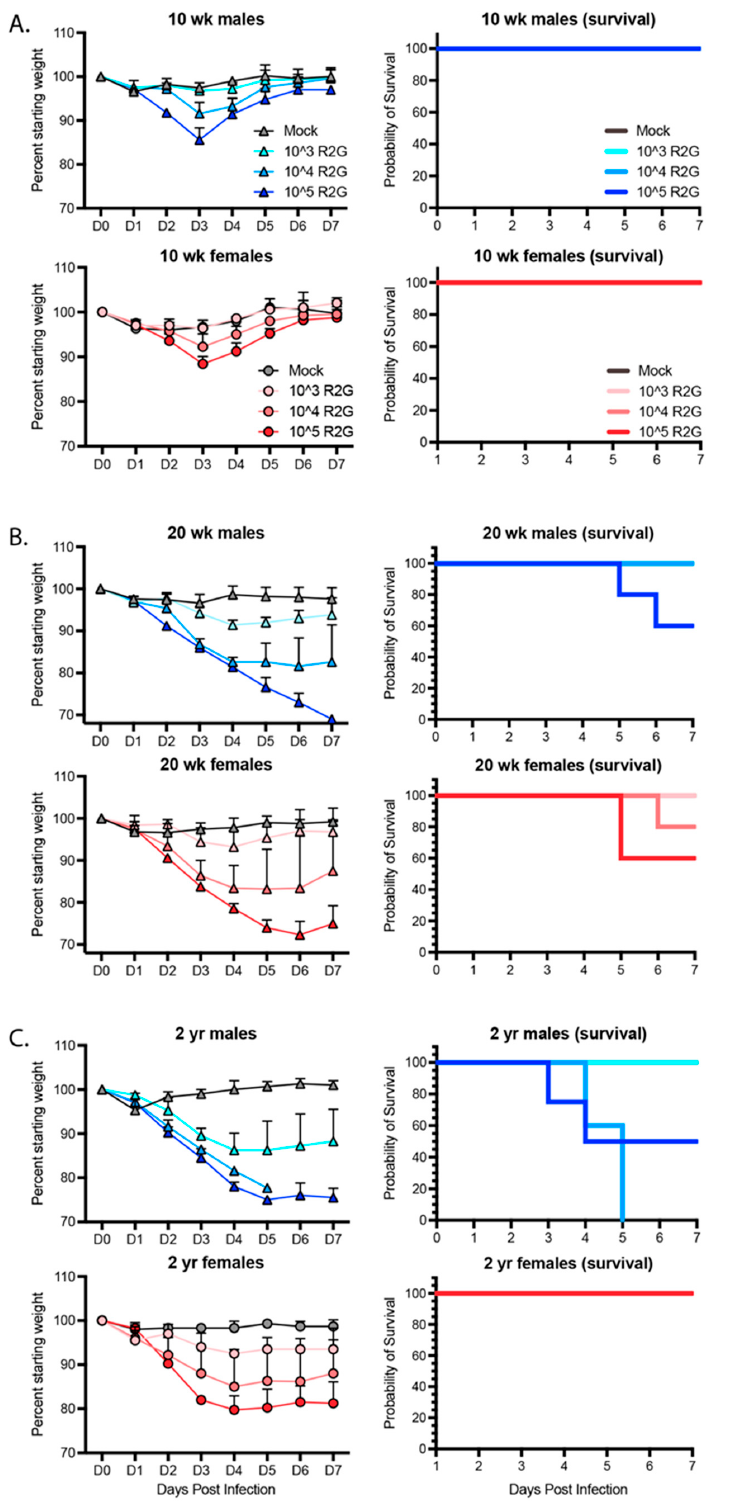
Figure 3. Dose, age, and sex dependent response to R2G in terms of weight loss and survival for 10 wk-old ( A ), 20 wk-old ( B ), and 2 yr-old ( C ) mice infected with 103, 104, or 105 PFU R2G, with 3–5 mice per cohort. Mice were infected with indicated doses (PFU) by intranasal administration and followed daily for weight loss. Mice were euthanized if they fell below 70% original weight or became otherwise moribund. Supplemental Figure S3 shows dose response for 2 yr-old male and female mice treated with 102, 103, or 104 PFU